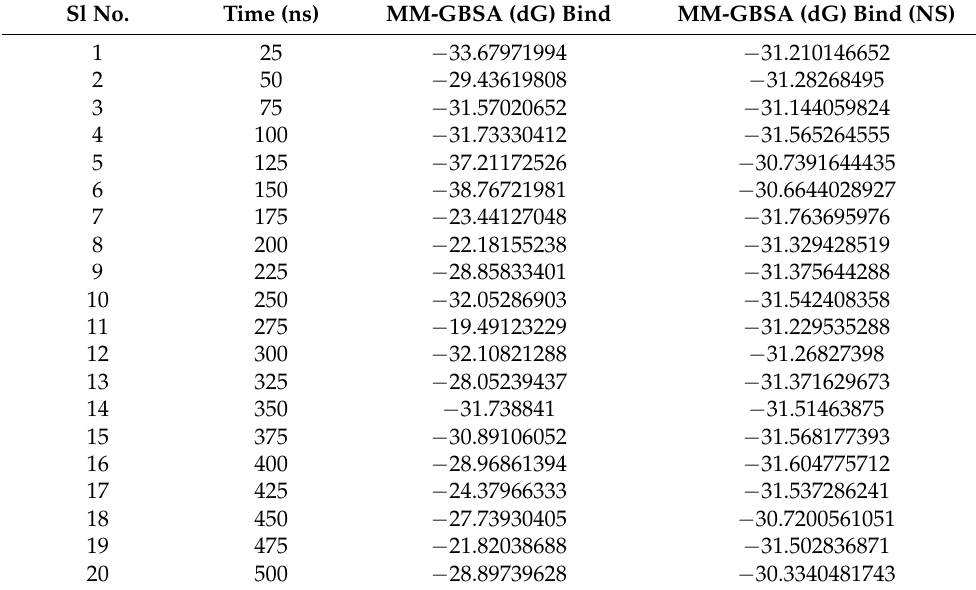
Table 2. GBSA binding scores with and without strain in kcal/mol for 20 snapshots at equal intervals of the simulation